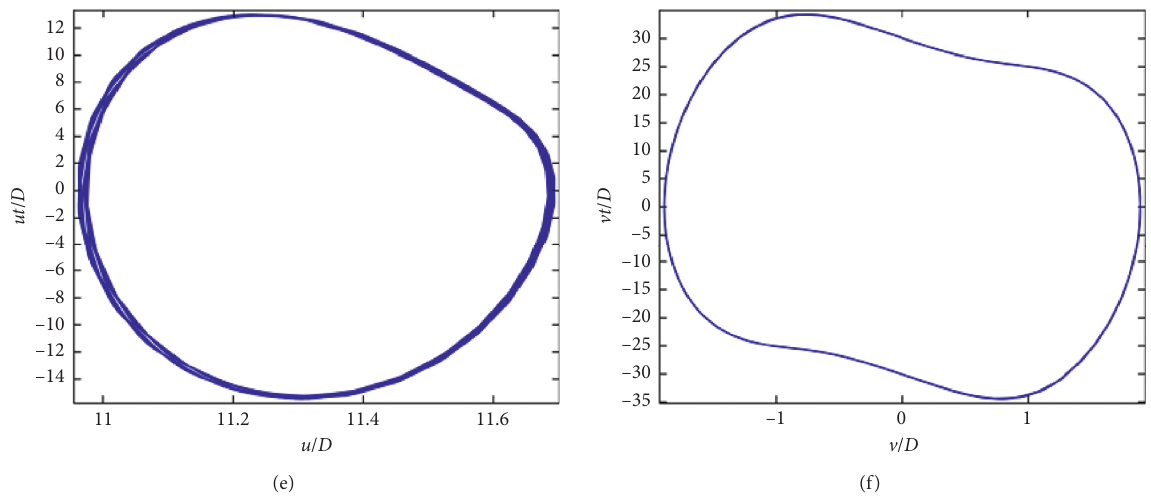
Figure 19: The phase diagram at the axial center of the marine riser under the condition of different gas-phase volume fractions considering the coupling effect: the phase diagram of (a) the in-line and (b) cross-flow with ε g � 0, (c) the in-line and (d) cross-flow with ε g � 0.7, and (e) the in-line and (f) cross-flow with ε g �